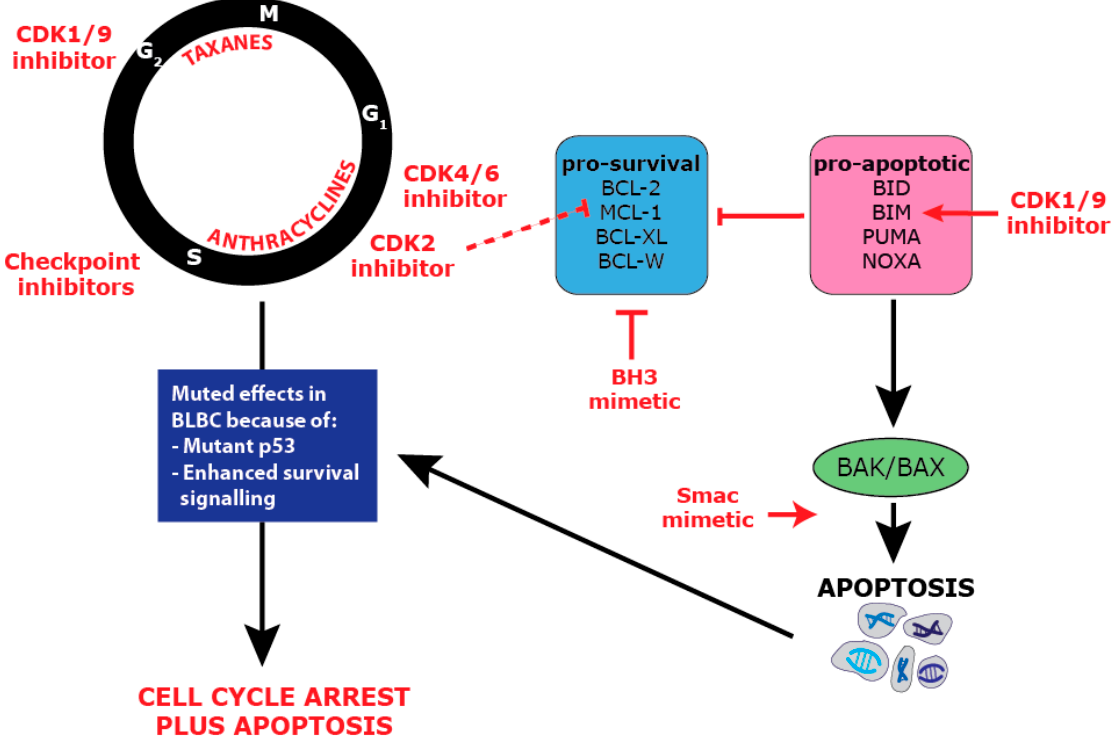
Figure 4. Combination anti-proliferative and pro-apoptotic therapy in BLBC.